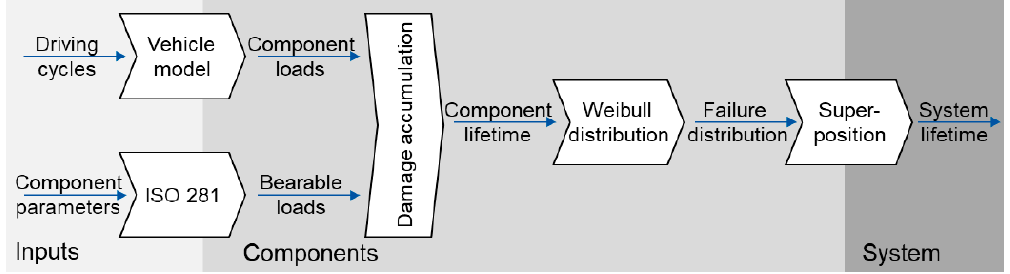
Figure 3. Approach for determining the system lifetime [28].